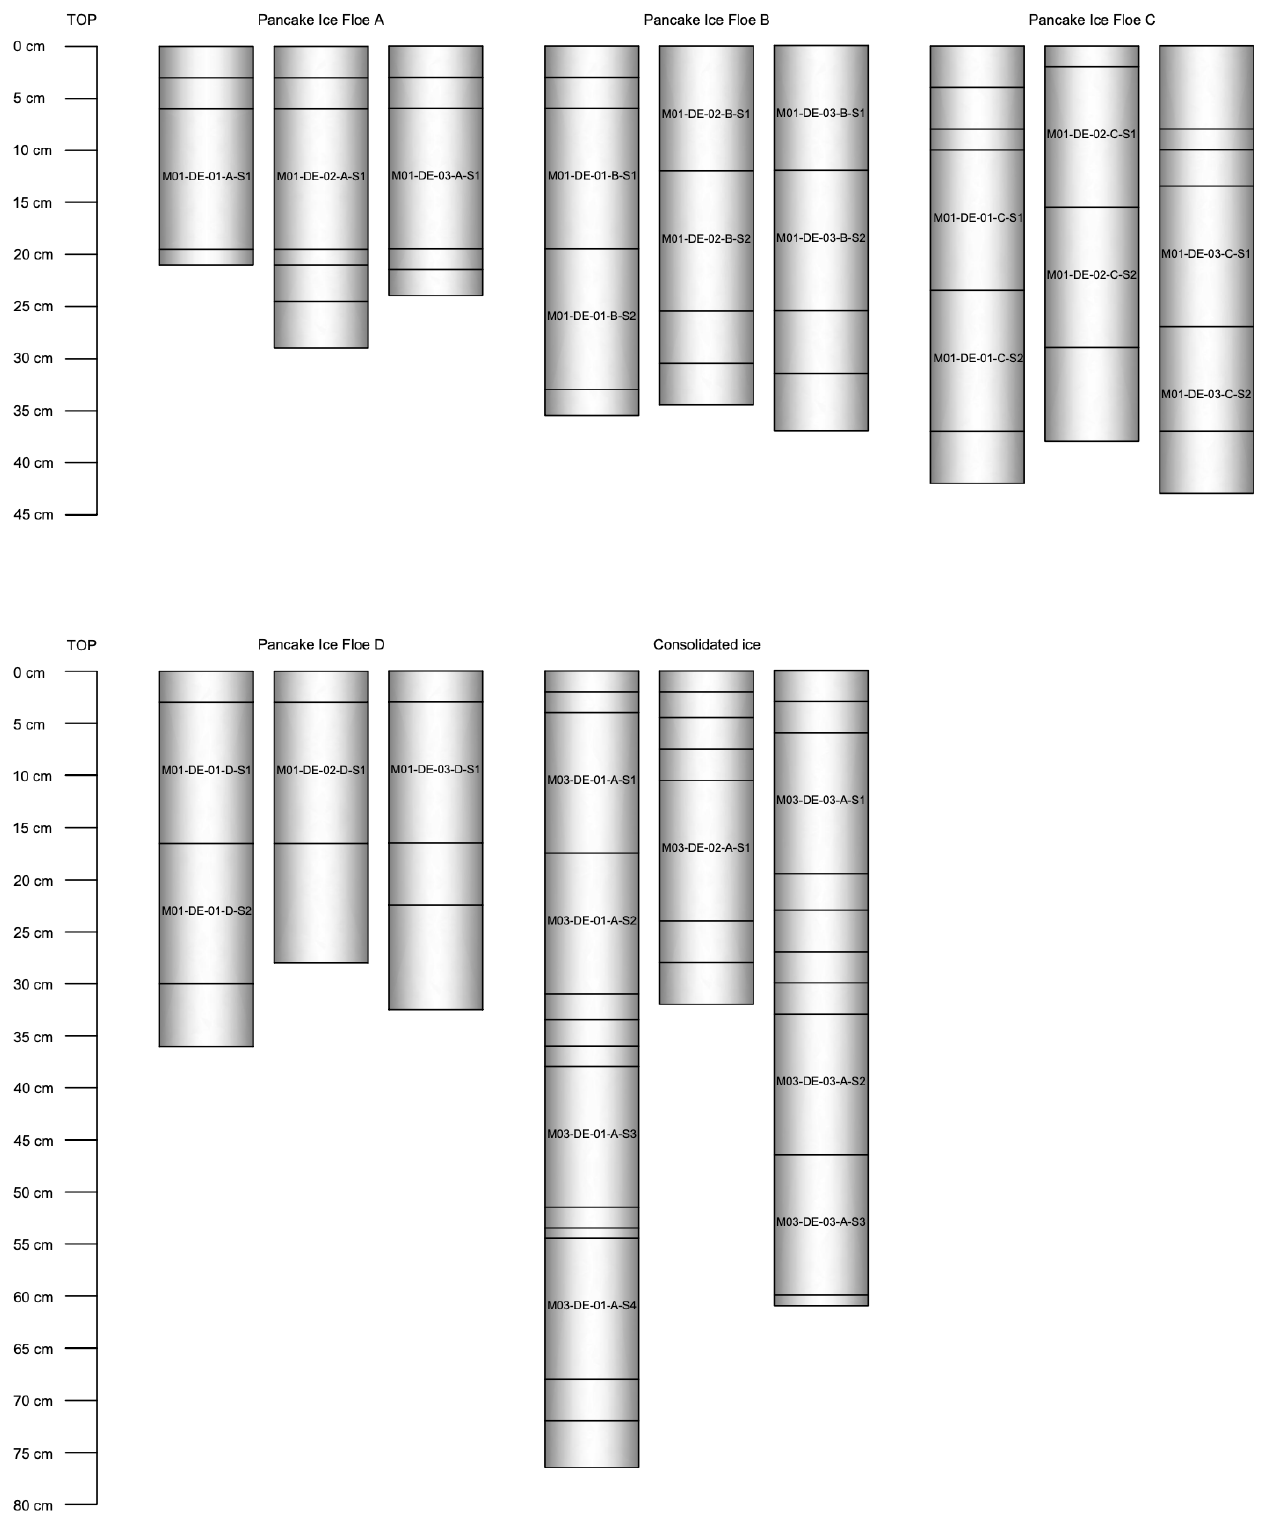
Figure B2. Schematic of the segmentation of 12 pancake ice and 3 pack ice cores subjected to compression testing with sample dimensions and corresponding core